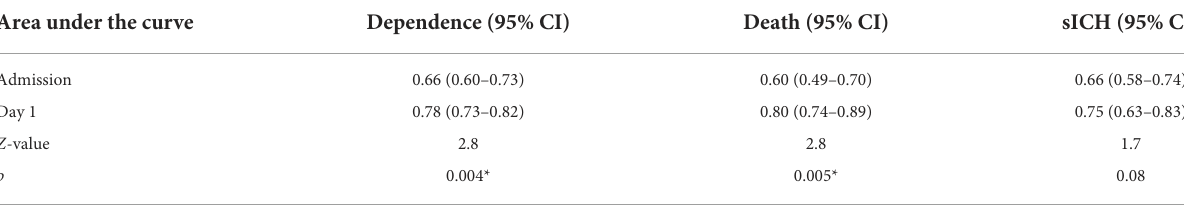
TABLE 5 Comparison of the area under ROC curve between admission and day 1 NLR in patients with IVT. Area under the curve